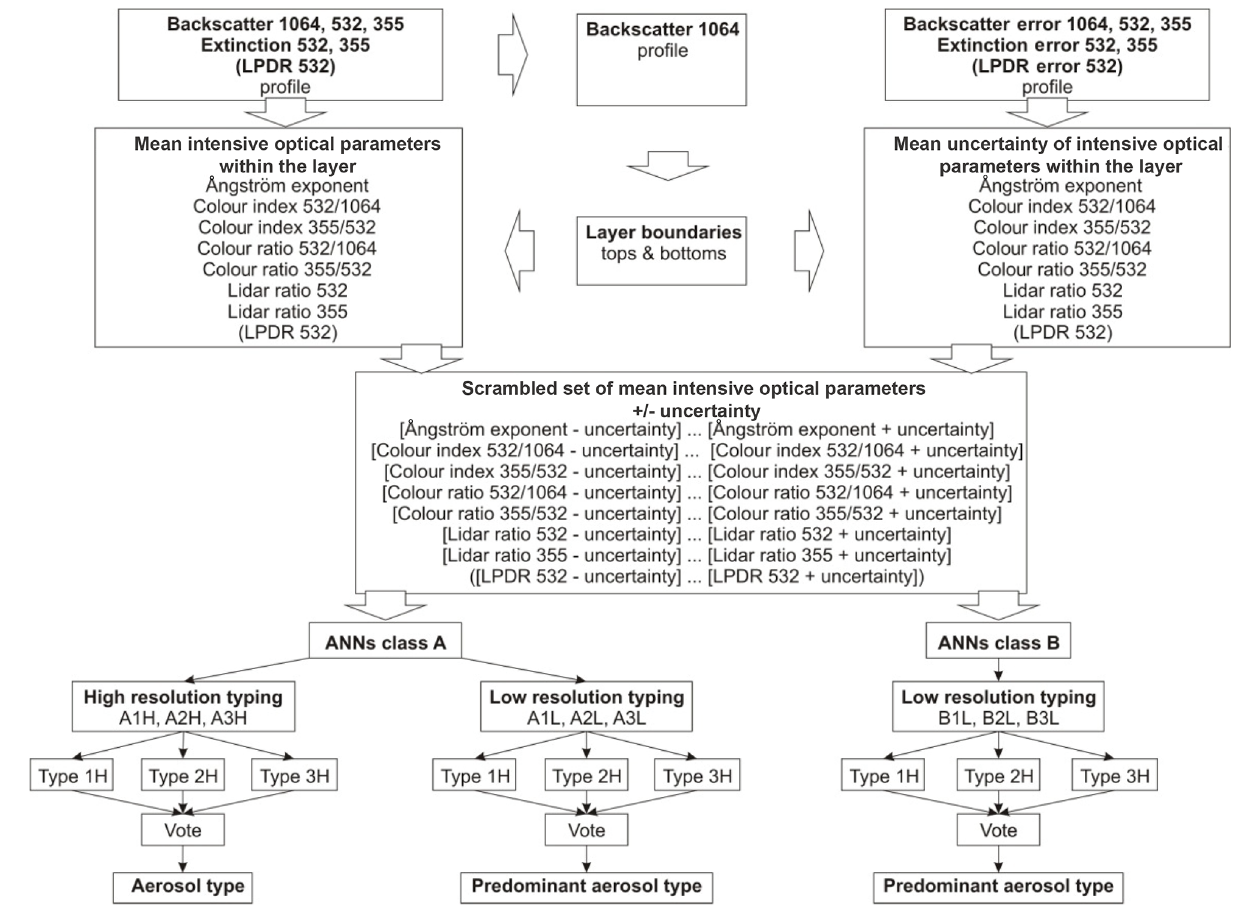
Figure 3. Schematics of the NATALI algorithm for aerosol